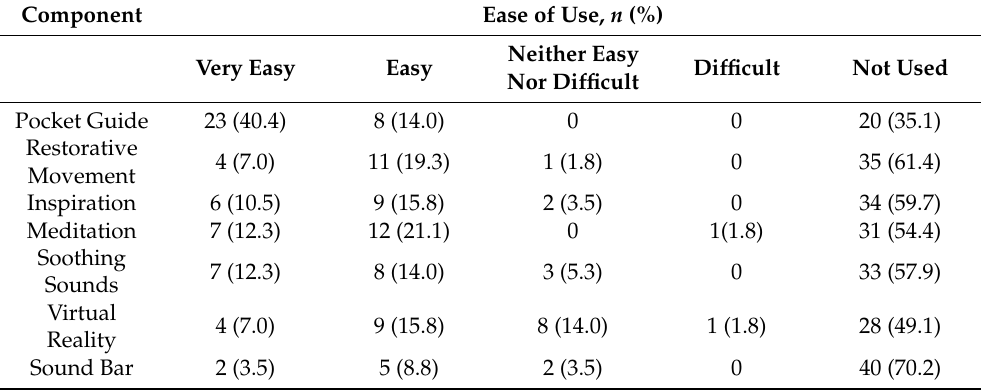
Table 9. Ease of Use of Room to Reflect Offerings *.